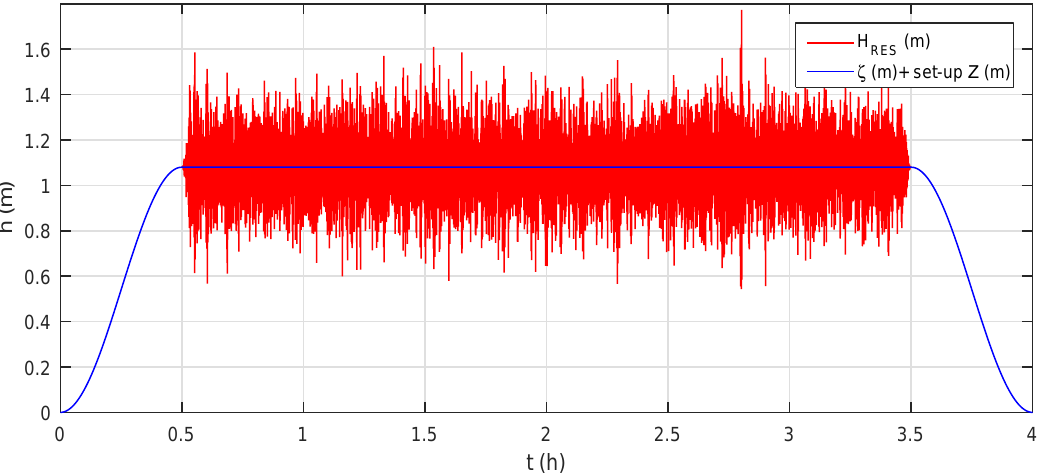
Figure 3. Example of final boundary condition at the shoreline refereed to the Mean Sea Level